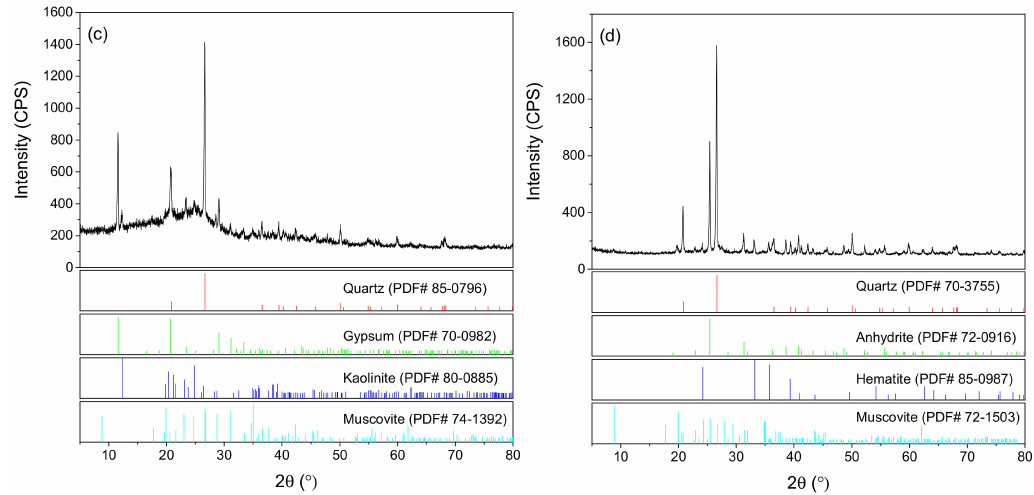
Figure 5. XRD patterns for coals and coal ashes: ( a ) Coal A, ( b ) coal ash A, ( c ) coal B, and ( d ) coal ash